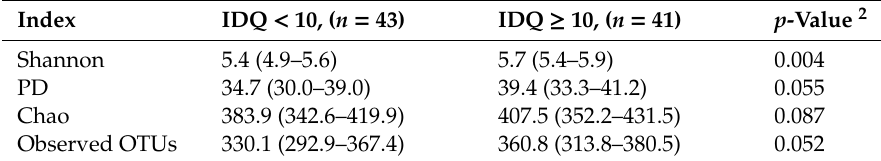
Table 3. Gut microbiota diversity indexes in the women with good (IDQ ≥ 10) and poor (IDQ < 10) dietary quality 1 .